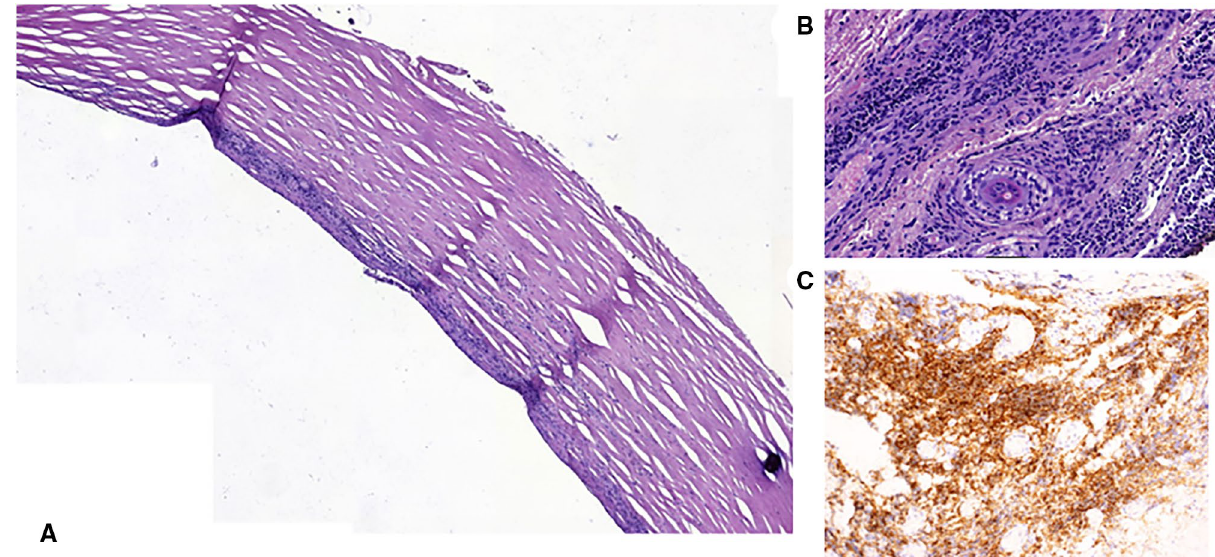
Figure 3. Histopathological findings after gold weight removal. ( a ) Micrograph showing a band of fibrous connective tissue with hyalinization and with visible area of lymphocytic infiltration on the surface (hematoxylin–eosin, × 20). ( b ) Micrograph showing significant inflammatory infiltration with clearly visible lymphocytes, part of the Meibomam gland and hyalinization (hematoxylin–eosin, × 20). ( c ) CD8 + cells with the